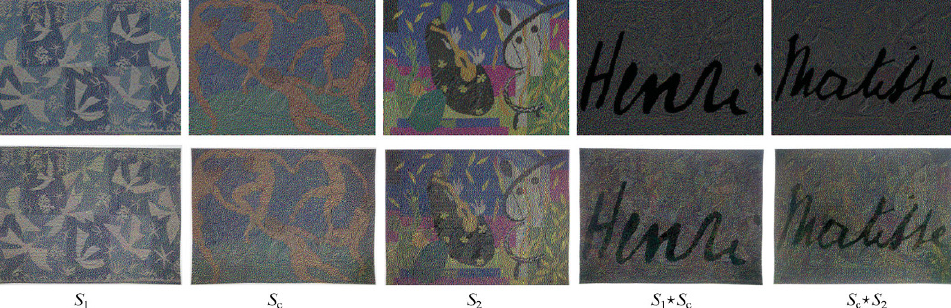
Fig. 6 Top: computed color EVCS results. Original images are 480 × 360 pixels. Bottom: output shares printed on transparencies. The two sheets on the right are the superimposition results of a common share and the corresponding share on the left. Input images are given in Fig. 11(top) in the